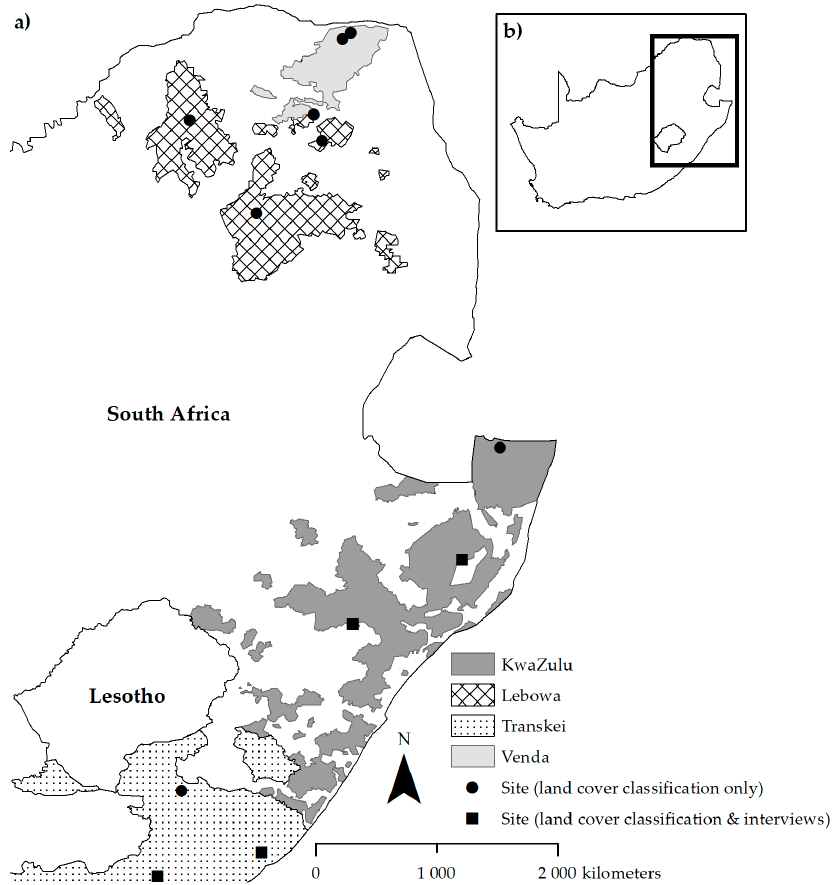
Figure 1. ( a ) The locations of study sites in four former homelands, including land cover survey sites and sites with combined land cover and interview-based surveys. ( b ) The inset map shows the location of the eastern former homelands within South Africa.